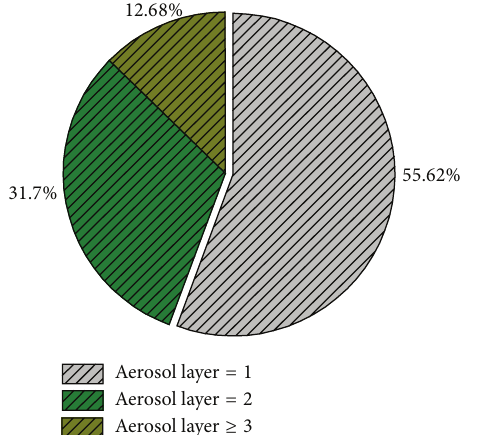
Figure 6: The percentage of vertical column total dust aerosol layer numbers identified from each of the CALIOP profiles over China during the period from 2007 to